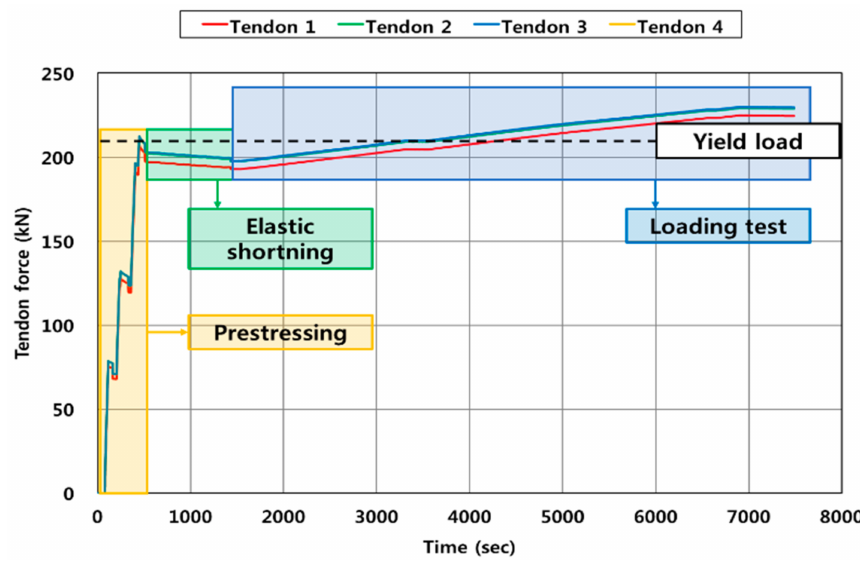
Figure 9. External tendon